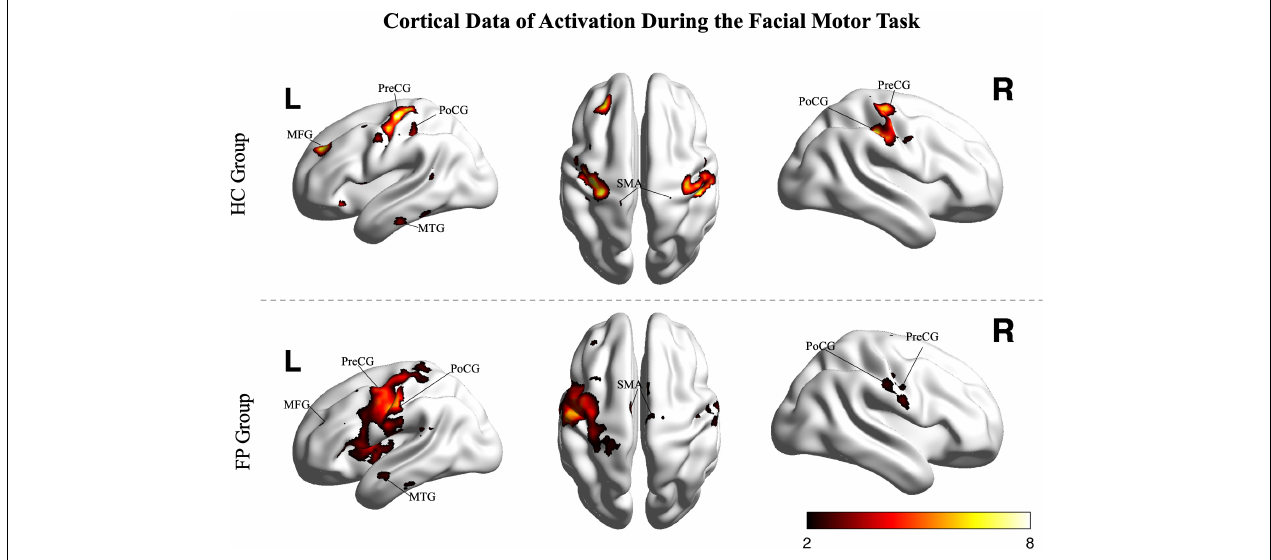
FIGURE 2 | Random effects group analysis of the facial smiling task. Activations (one sample t -test, p < 0.05, FDR corrected) in response to blocked (15 s) movement of the bilateral mouth angle are shown superimposed on a template cortex. Images from the control group ( n = 15) are shown in the upper part of the figure, while images from the patients ( n = 22) are shown in the lower part. PoCG, postcentral gyrus; PreCG, precentral gyrus; SMA, supplementary motor area; MFG, middle frontal gyrus; MTG, middle temporal gyrus; R, right; L, left; FP, facial paralysis patients; HC, healthy controls. Color bar shows the t -value.